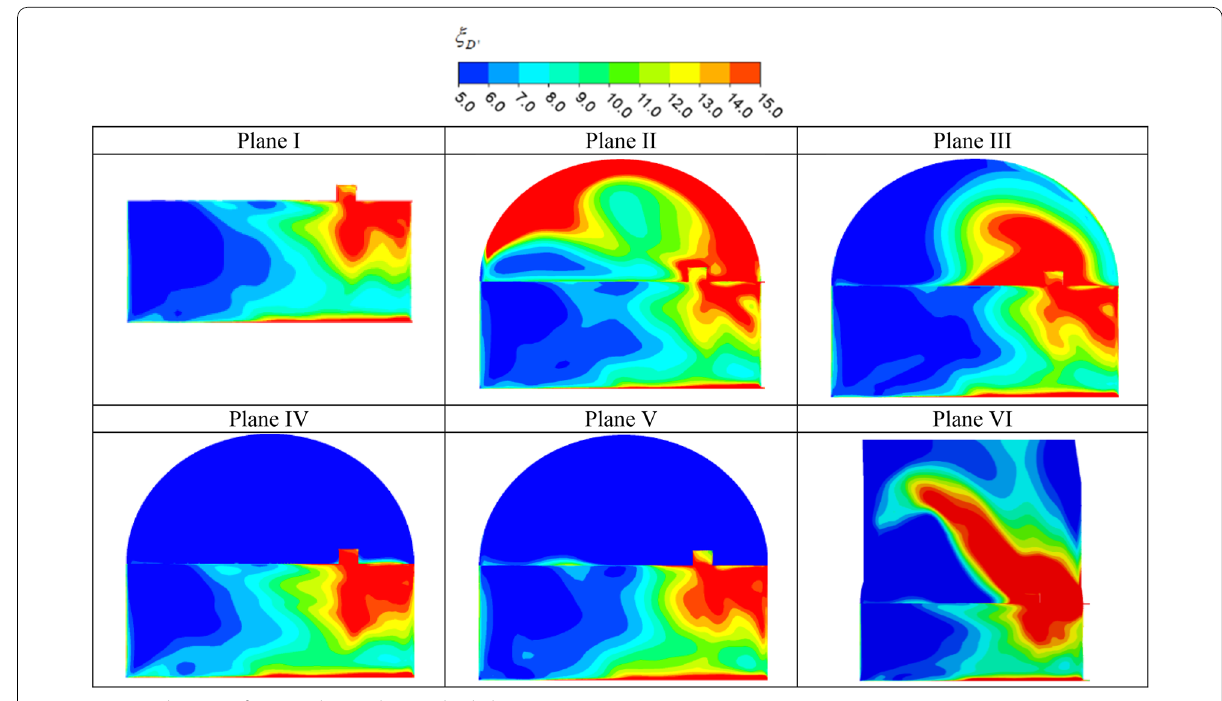
Figure 16 Distributions of entropy loss on longitudinal planes